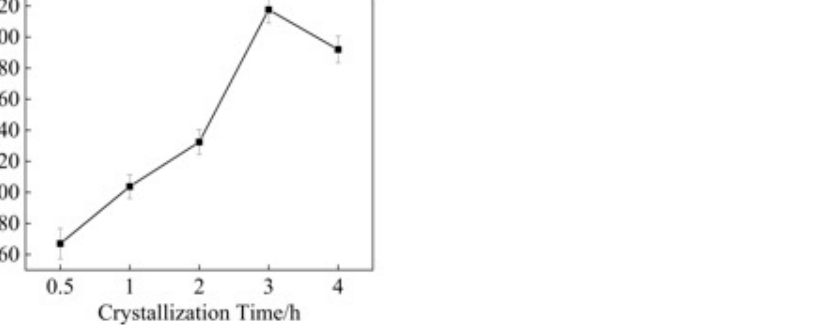
Figure 16. Effects of crystallization time on the acid and alkali resistances of the microcrystalline glass. 3.4. Effects of Microcrystallization on the Toxic Leaching Characteristics of Heavy Metals